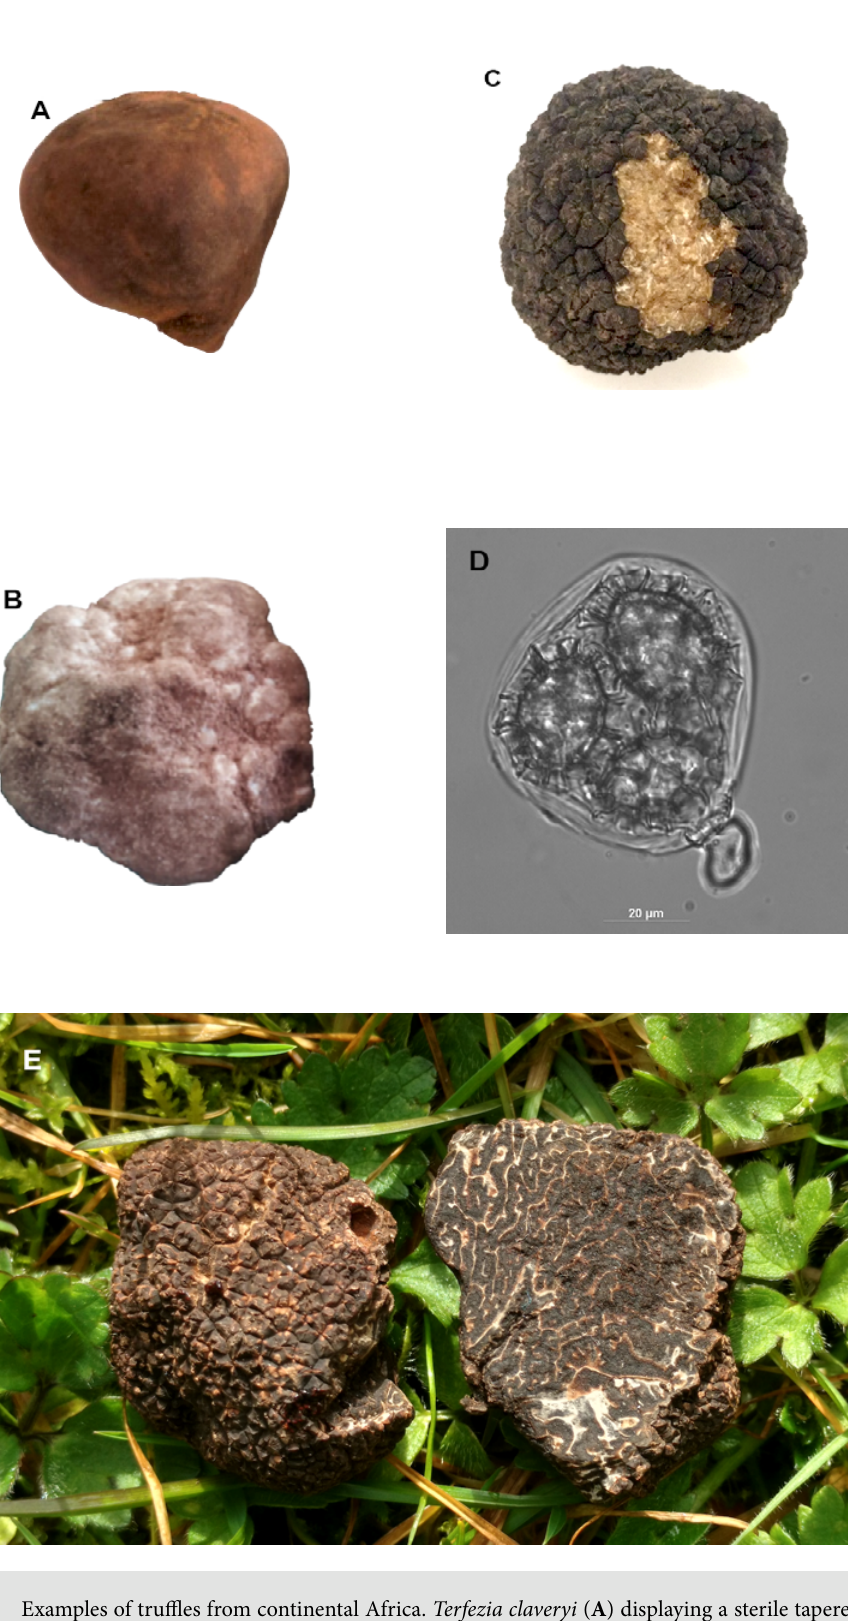
Fig. 1 Examples of truffles from continental Africa. Terfezia claveryi ( A ) displaying a sterile tapered base and orange brownish-red peridium. Tuber oligospermum ( B ) displaying a subglobose fruitbody with a whit- ish peridium. Tuber aestivum (syn. uncinatum ) displaying a warted peridium and light-brown gleba, spores ( C ) ornamented with a coarse irregular reticulum, and three ascospores per asci ( D ). Tuber melanosporum ( E ) displaying a warted peridium and gleba intersected by white veins, reddening with exposure to air. The photographs were taken by the corresponding author, excluding image ( D ), which was taken by Philip